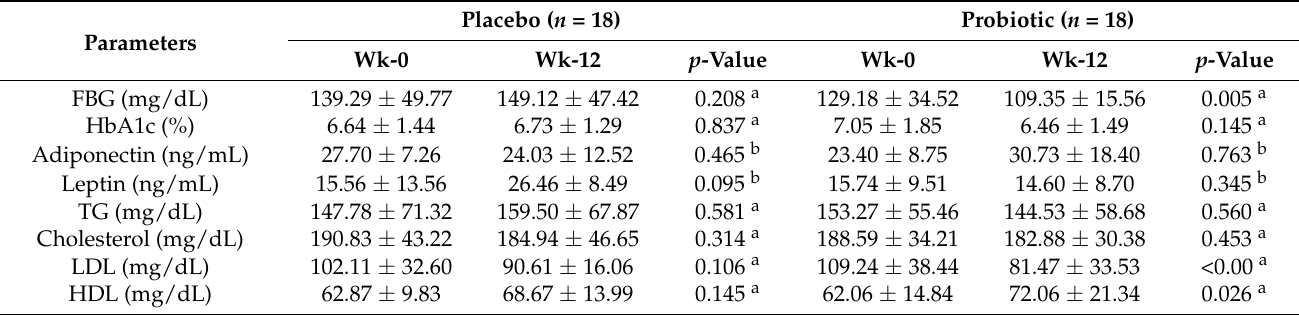
Table 2. Blood levels of FBG, HbA1c, adiponectin, leptin and lipid profiles at baseline and at the end of the